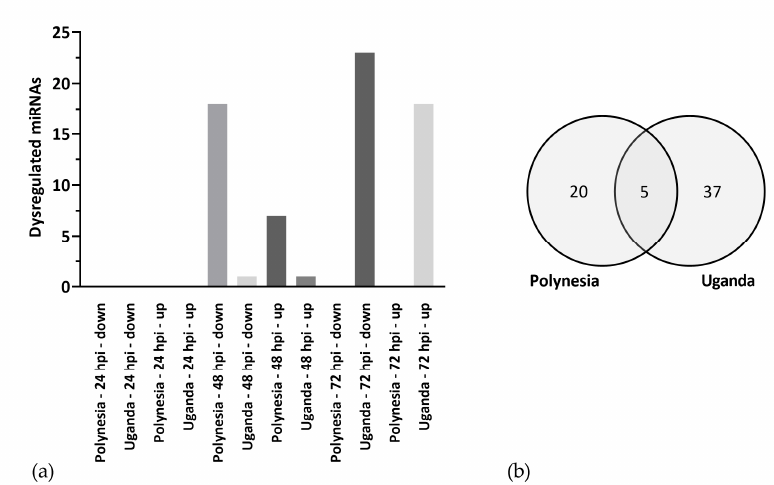
Figure 7. Level of extracellular vesicles (EV)-derived miRNAs. ( a ) Significantly ( p -value ≤ 0.05) ≥ two-fold dysregulated mature miRNAs, which were incorporated into EVs during infection of lt-NES ® cells with either ZIKV Polynesia or Uganda. ( b ) EV-derived miRNAs with levels significantly ( p -value ≤ 0.05) altered ( ≥ two-fold) following infection with ZIKV Polynesia and Uganda at any time point.